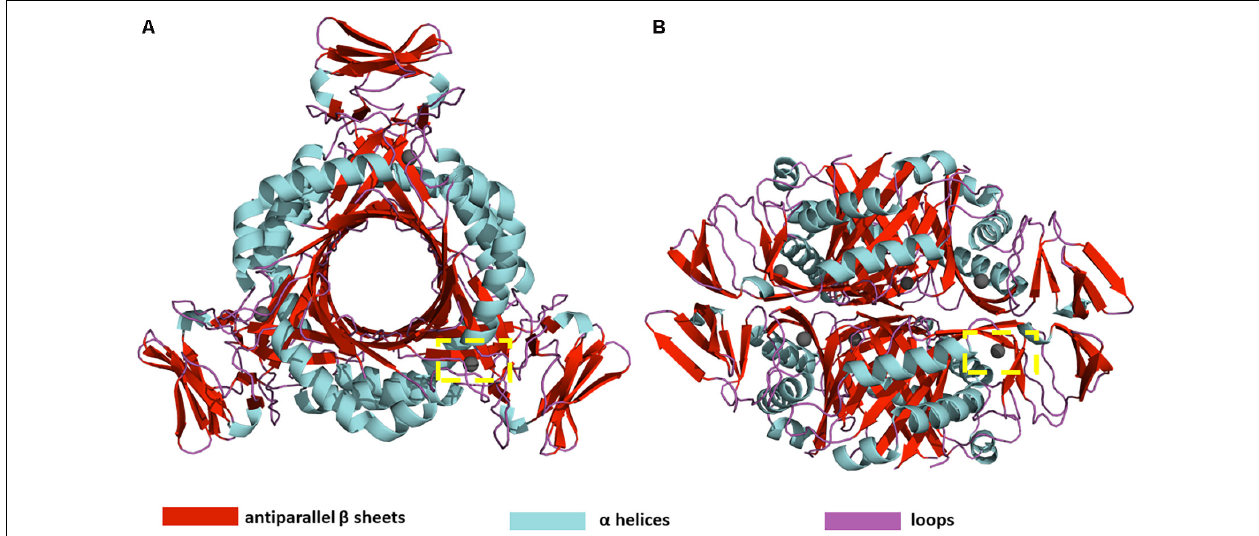
FIGURE 1 | (A) Top view (B) Side view of P. falciparum PTPS 3D structure (PDB: 1Y13). The 3D structure is composed of a dimer of trimers with D3 symmetry (Nar et al., 1994). The yellow dashed box shows the location of one of the six active